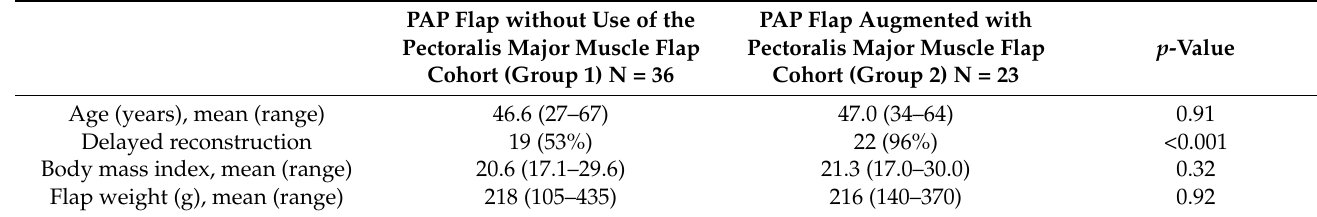
Table 1. Patient